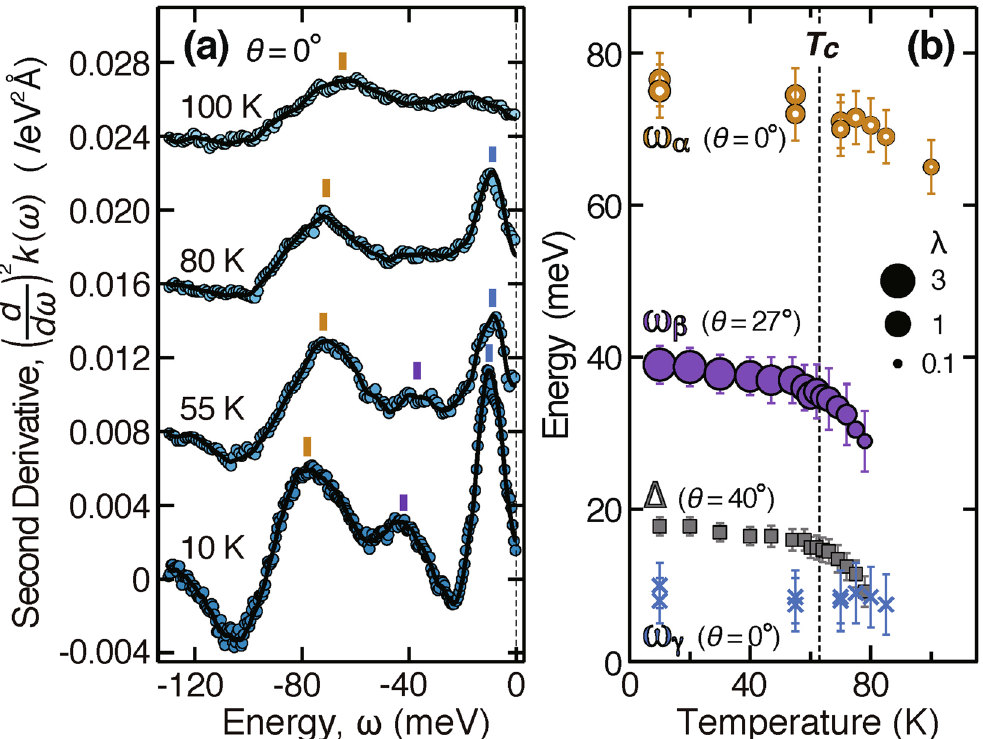
Figure 3. Temperature dependence of OD63. ( a ) Second energy derivative of nodal dispersion, ( d / d ω ) 2 k ( ω ), at T = 10, 55, 80, and 100 K, offset from each other by 0.008 eV − 2 Å − 1 . ( b ) Energies of a nodal α kink at θ = 0° (brown open circles), an off-nodal β kink at θ = 27° (purple filled circles), a nodal γ kink at θ = 0° (blue crosses), and an antinodal gap at θ = 40° (grey squares), observed across T c = 63 K. Circle size represents the kink strength. The error bars for the kink energy and gap energy represent the uncertainty in determining the peak position of ( d / d ω ) 2 k ( ω ) and the EDC at the Fermi momentum,